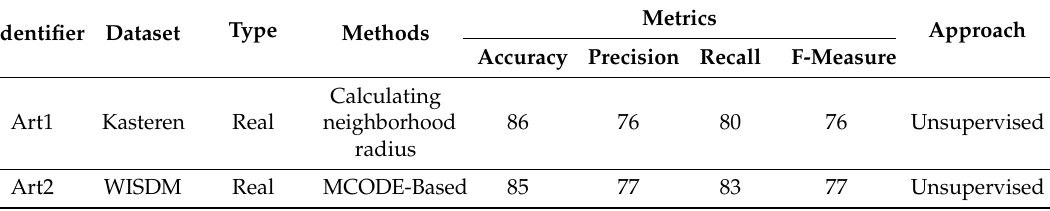
Table 7. General information of publication analyzed in a meta-analytical matrix.